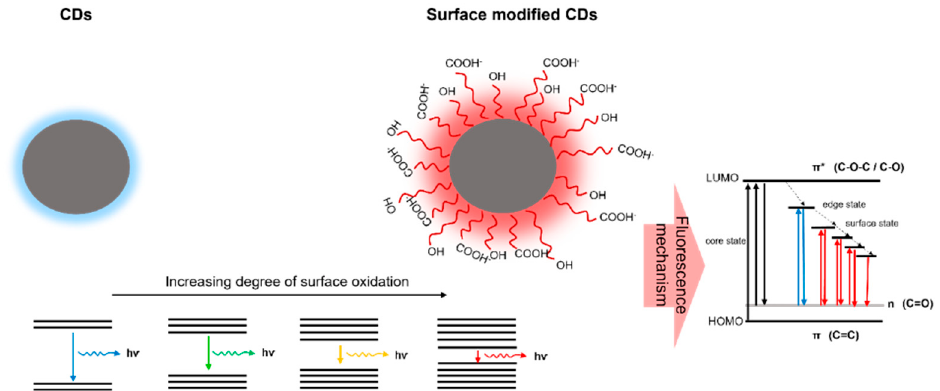
Figure 3. Scheme illustration of tunable PL of CDs with different degrees of oxidation. Table 7. Summary of the synthesis of CDs from waste products.